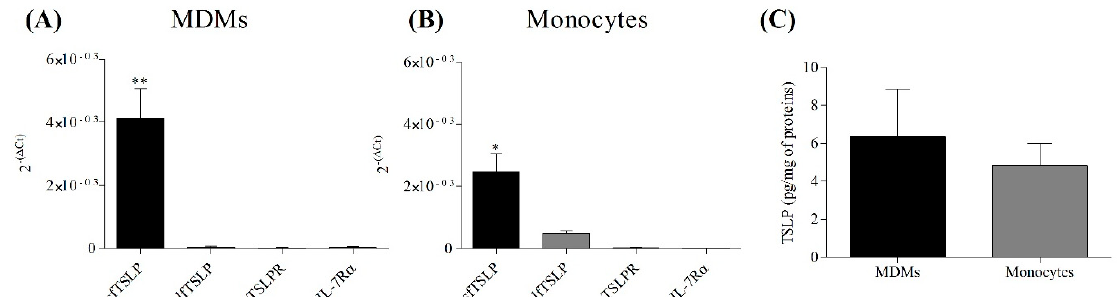
Figure 4. Constitutive expression of sfTSLP, lfTSLP, TSLPR, and IL-7R α mRNAs and intracellular concentration of TSLP protein in MDMs and monocytes. MDMs (4.5 × 10 6 cells/well) ( A ) and freshly purified monocytes (4.5 × 10 6 cells/well) ( B ) were lysed with RNA lysis buffer to evaluate the expression of sfTSLP, lfTSLP, TSLPR and IL-7R α mRNAs by quantitative RT-PCR ( A , B ). Total TSLP intracellular concentrations in MDMs and monocytes were evaluated by ELISA ( C ). Data are mean ± SD of 6 independent experiments obtained from different healthy donors. * p < 0.05 when compared to lfTSLP, TSLPR, IL-7R α . ** p < 0.01 when compared to lfTSLP, TSLPR, IL-7R α .